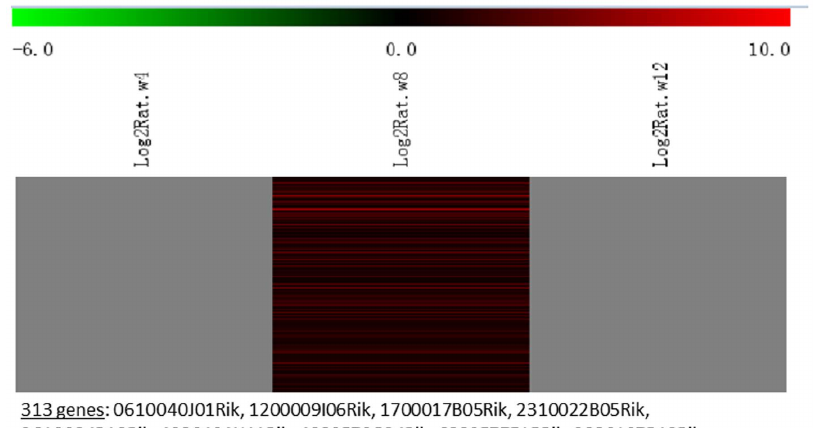
Figure 7. The Heat Map and the list of genes which were up-regulated transiently at the middle stage (8 weeks of age). There were a total of 313 genes in the list.